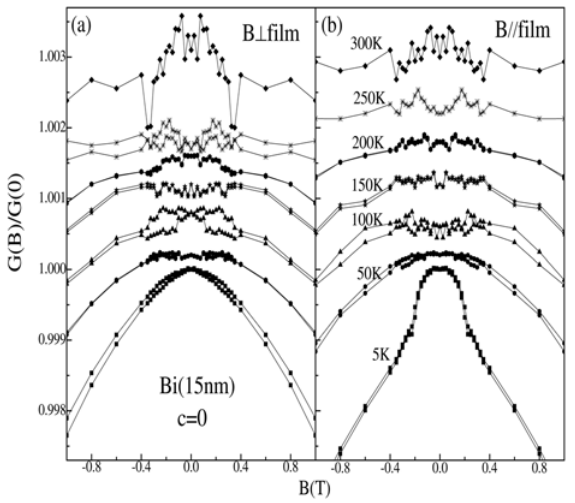
Fig. 3. Low-field part of magnetoconductance G(B) normalized to zero field value G(B=0) in pure Bi film. (a) Field applied perpendicular to film plane, and (b) transverse magnetoconductance. Black symbols and lines are the loop branches for applied fields from +9T to -9T whereas in gray color are branches from -9T to